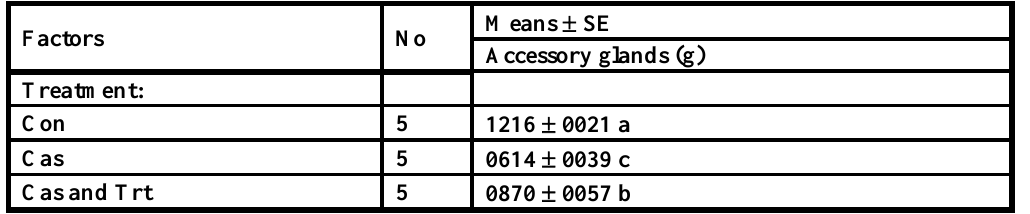
Table 6 Effects of N. sativa oil on accessory glands weight in castrated male